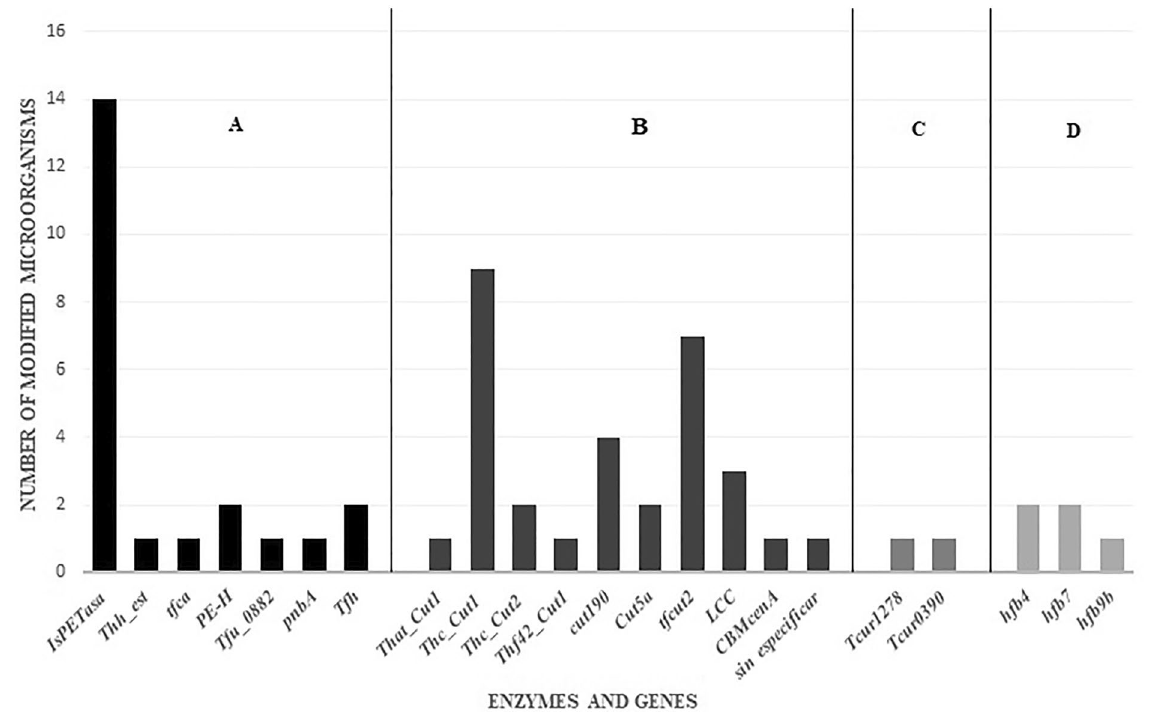
Fig. 2 Enzymes and genes used in the genetic manipulation of microorganisms to increase their capacity to degrade polyethylene tereph- thalate PET. A Esterases; B Cutinases; C Unspecified hydrolases; D Fungal